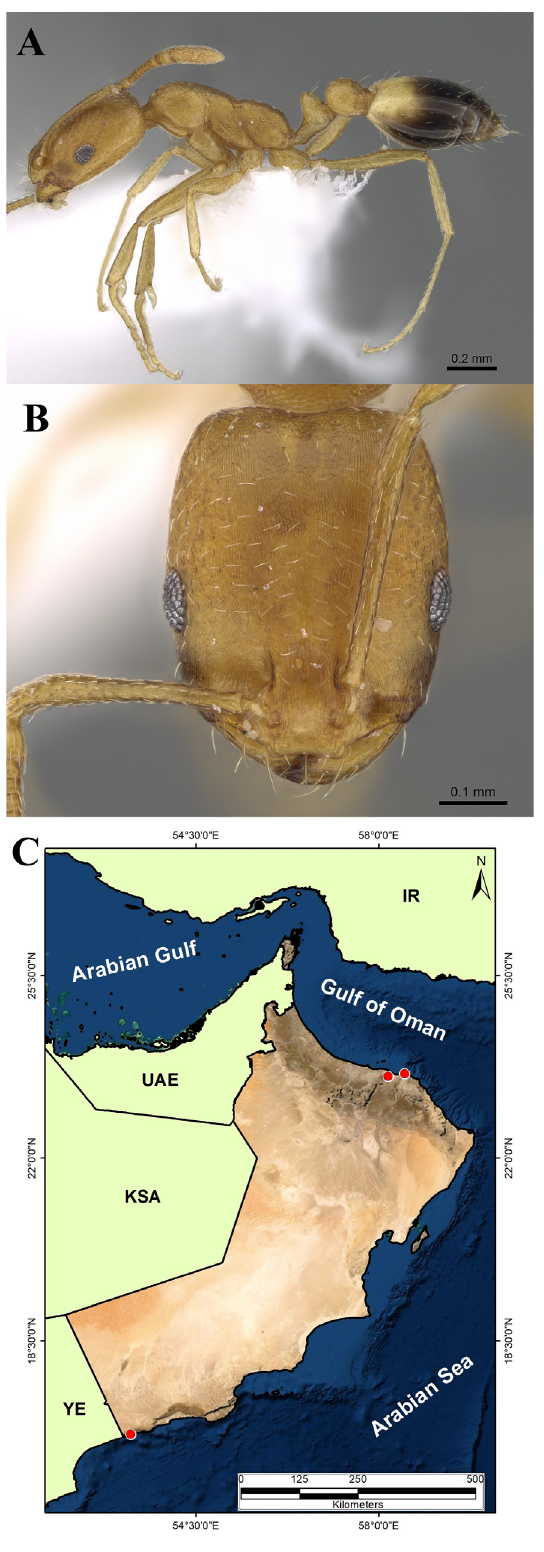
Fig. 38. Monomorium sahlbergi Emery, 1898, worker (CASENT0922304, AntWeb.org (Michele Esposito)). A . Body in profile. B . Head in full-face view. C . Distribution